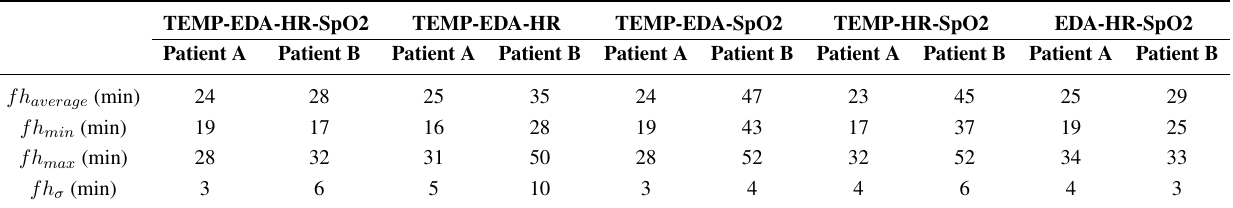
Table 3. Prediction horizons for all the combinations of features for Patients A and B. TEMP, skin temperature; EDA, electrodermal activity; HR, heart rate; Sp02, peripheral capillary oxygen